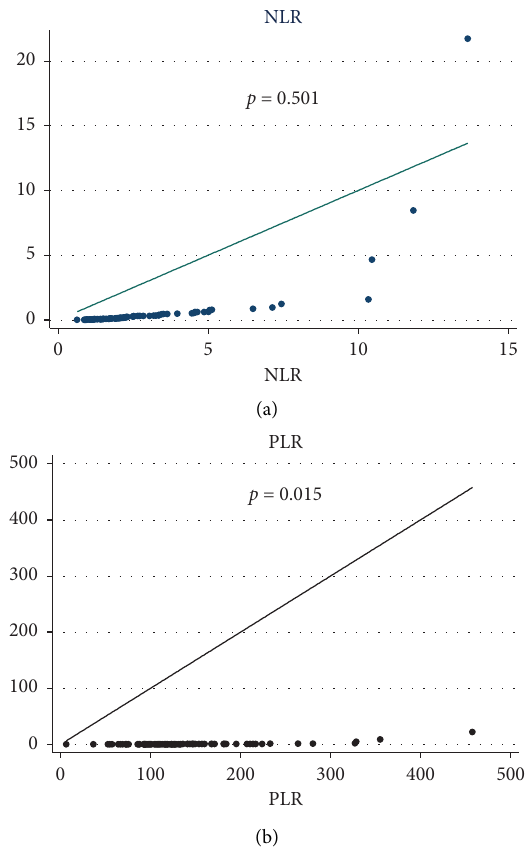
Figure 2: Correlation between NLR, PLR, and hs-CRP in nondialysis patients with chronic kidney disease using Spearman’s correlation test. NLR: neutrophil-to-lymphocyte ratio; PLR: platelet-to-lymphocyte ratio; and hs-CPR: high sensitivity C-reactive protein.